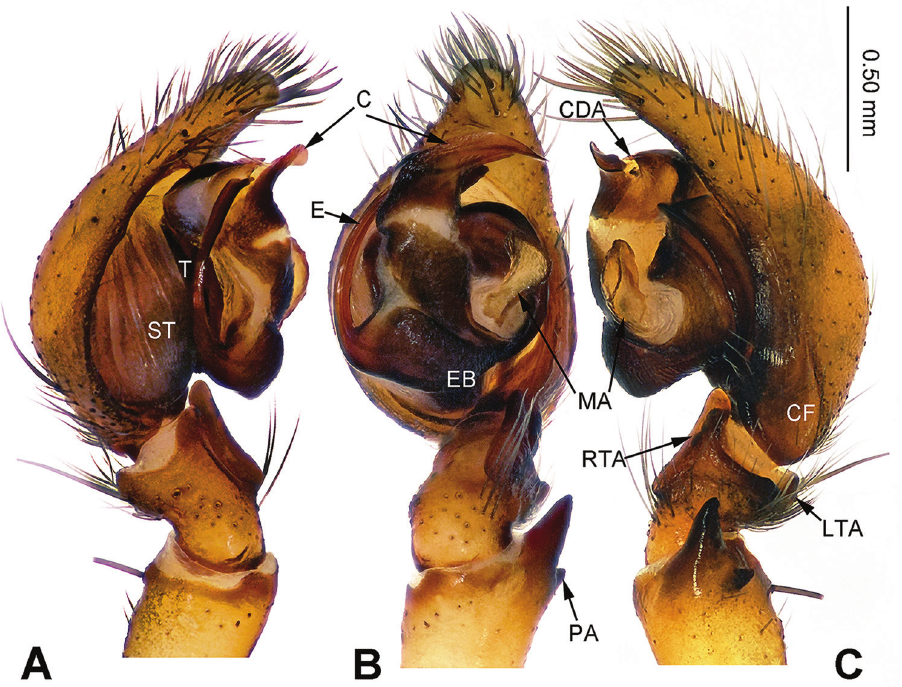
Figure 9. Left male palp of Sinodraconarius yui sp. n., holotype. A Prolateral view B Ventral view C Ret- rolateral view. Scale bar equal for A, B, C